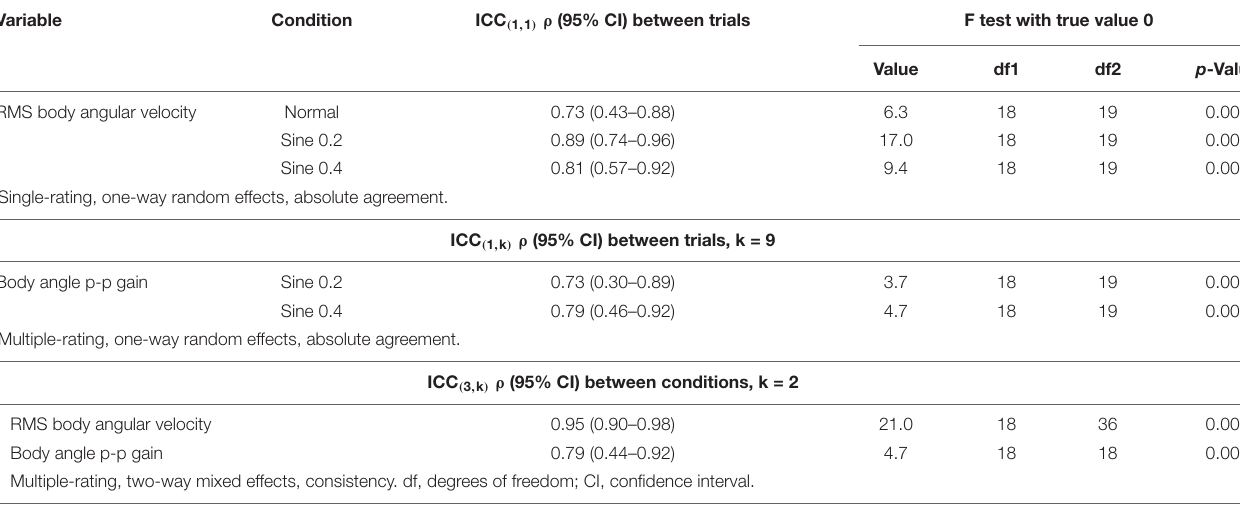
TABLE 3 | Ranking in increasing order of RMS body angular velocity and body angle p-p gain (ratio of body to footplate angle) from averaged results of 2 trials. RMS body angular velocity